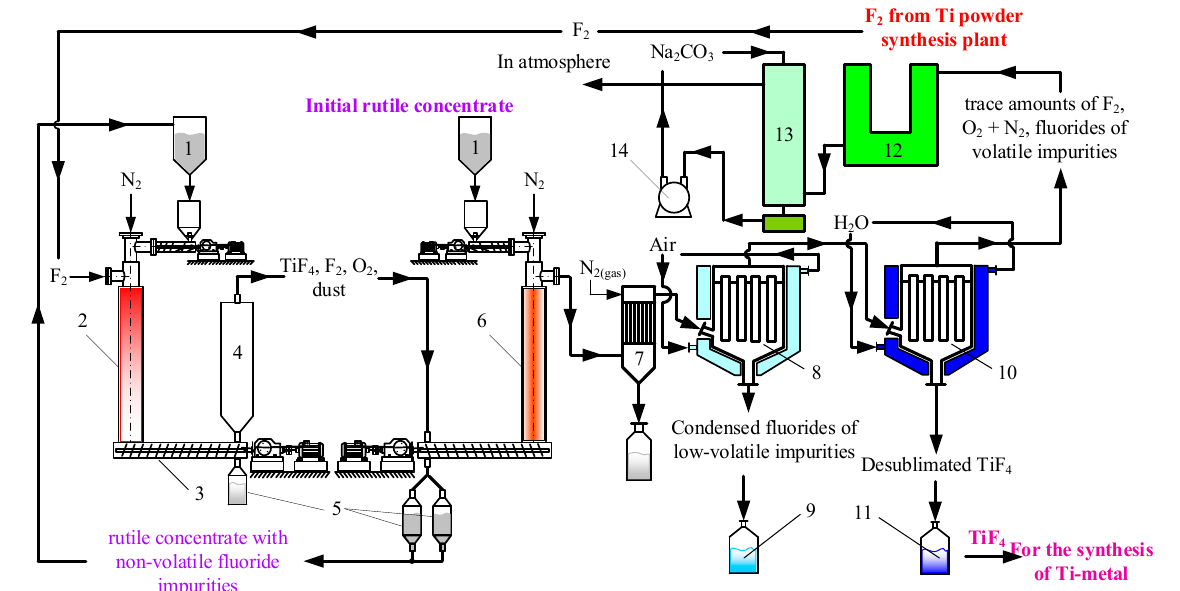
Figure 7. Apparatus and technological scheme for fluorination of rutile concentrate with elemental fluorine.1—Bunker with the original rutile concentrate; 2—Flame reactor; 3—Reactor for unloading fluoride cinder; 4—Container for the separation of non-volatile fluorides and non-fluorinated rutile concentrate; 5—Bunkers for collecting solid phase; 6—Reactor for capturing F 2 from the first stage of fluorination; 7—Filter; 8—Filter-cooler of the gas phase; 9—Tank for condensed fluorides of low-volatile impurities; 10—TiF 4 desublimator; 11—Container for collecting TiF 4 powder; 12—Scrubber for cleaning fluorinated gases; 13—Column for post-treatment of waste gases from fluorine-containing components; 14—Pump.